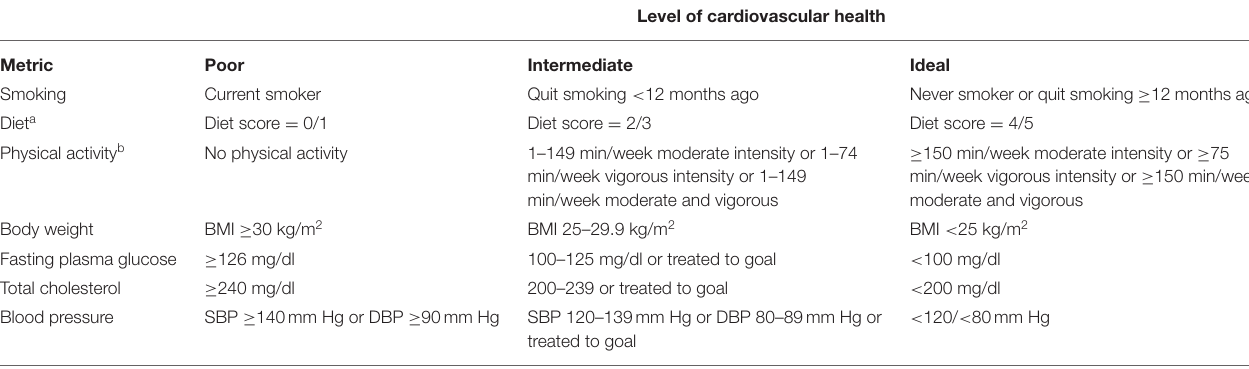
TABLE 1 | Definitions of cardiovascular health metrics from the 2020 Strategic Impact Goals Committee of the American Heart Association.